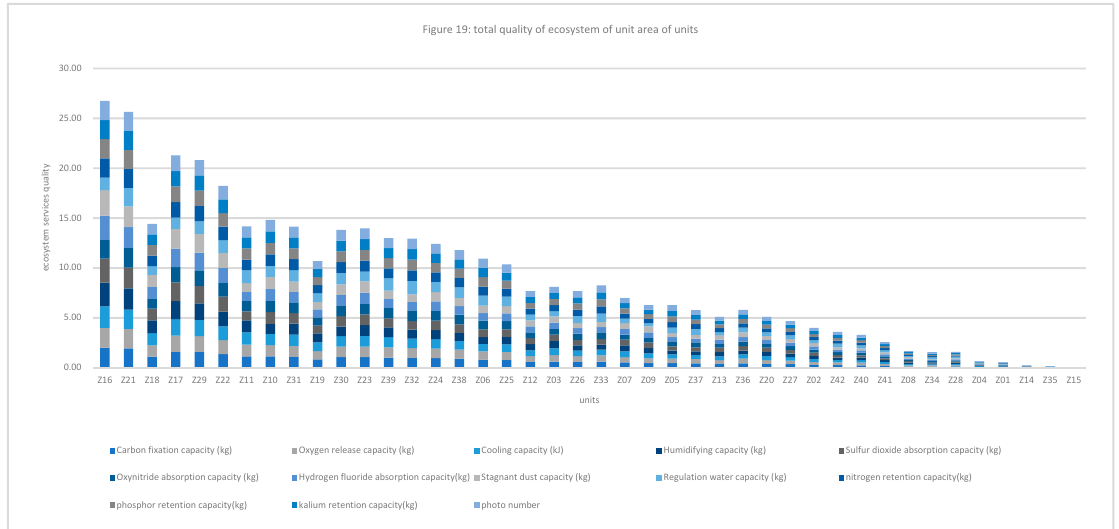
Figure 19: total quality of ecosystem of unit area of units